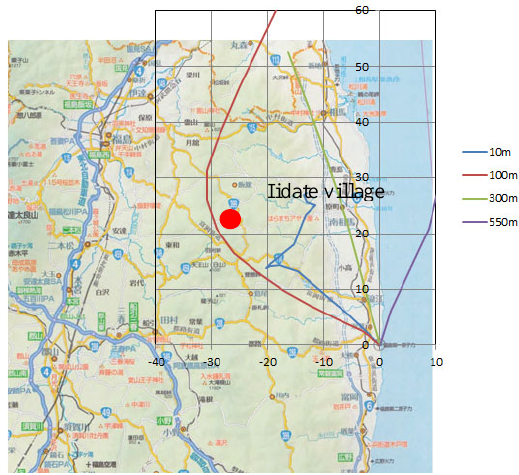
Figure 2. Particle flying traces estimated from wind directions and speeds on March 12.